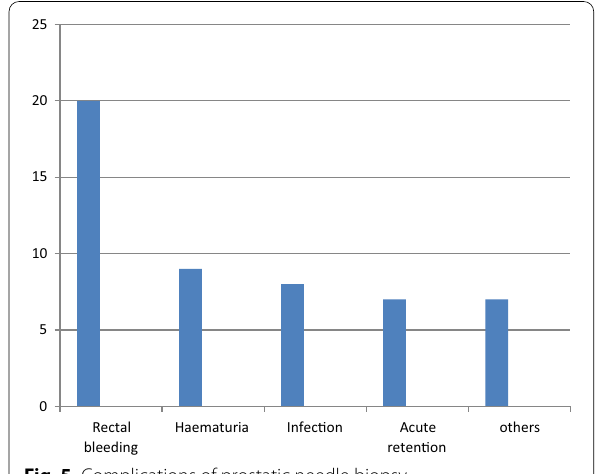
Fig. 5 Complications of prostatic needle